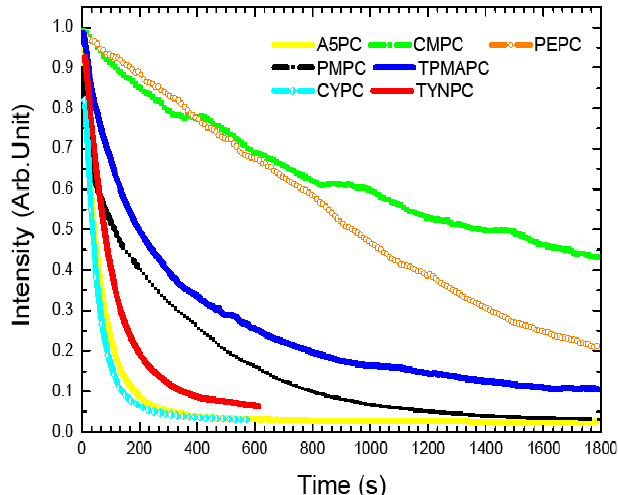
Figure 6. Evolution of PL intensity as a function of illumination time for PEPC, PMPC, CMPC, A5PC, TPMAPC, TNYPC and CYPC thin films in air. The excitation source is the 325 nm line of a HeCd laser, the laser power is fixed at 7 mW (corresponding to a fluence 0.175 W·cm −2 ). The PL intensities are normalized to 1 at t = 0